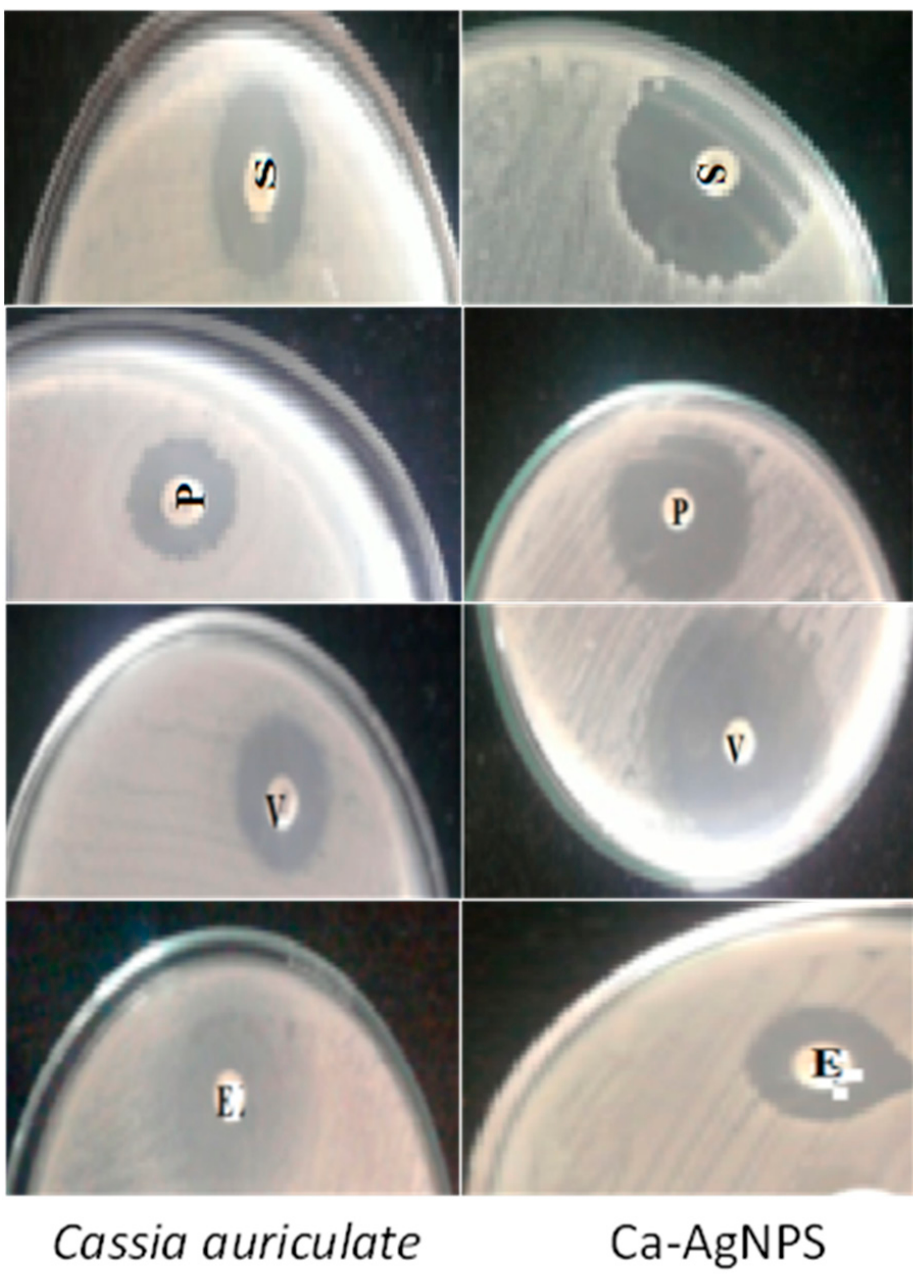
Figure 4. Antimicrobial activity of Ca-AgNPs; S-Staphylococcus epidermidis; P- Pseudomonas aeruginosa ; V- Vibrio cholerae ; and E- Escherichia coli . Table 1. Zone of Inhibition of four different bacterial strains using the concentrations (75 µg/mL) of the Cassia auriculate flower extract and Cp-AgNPs.